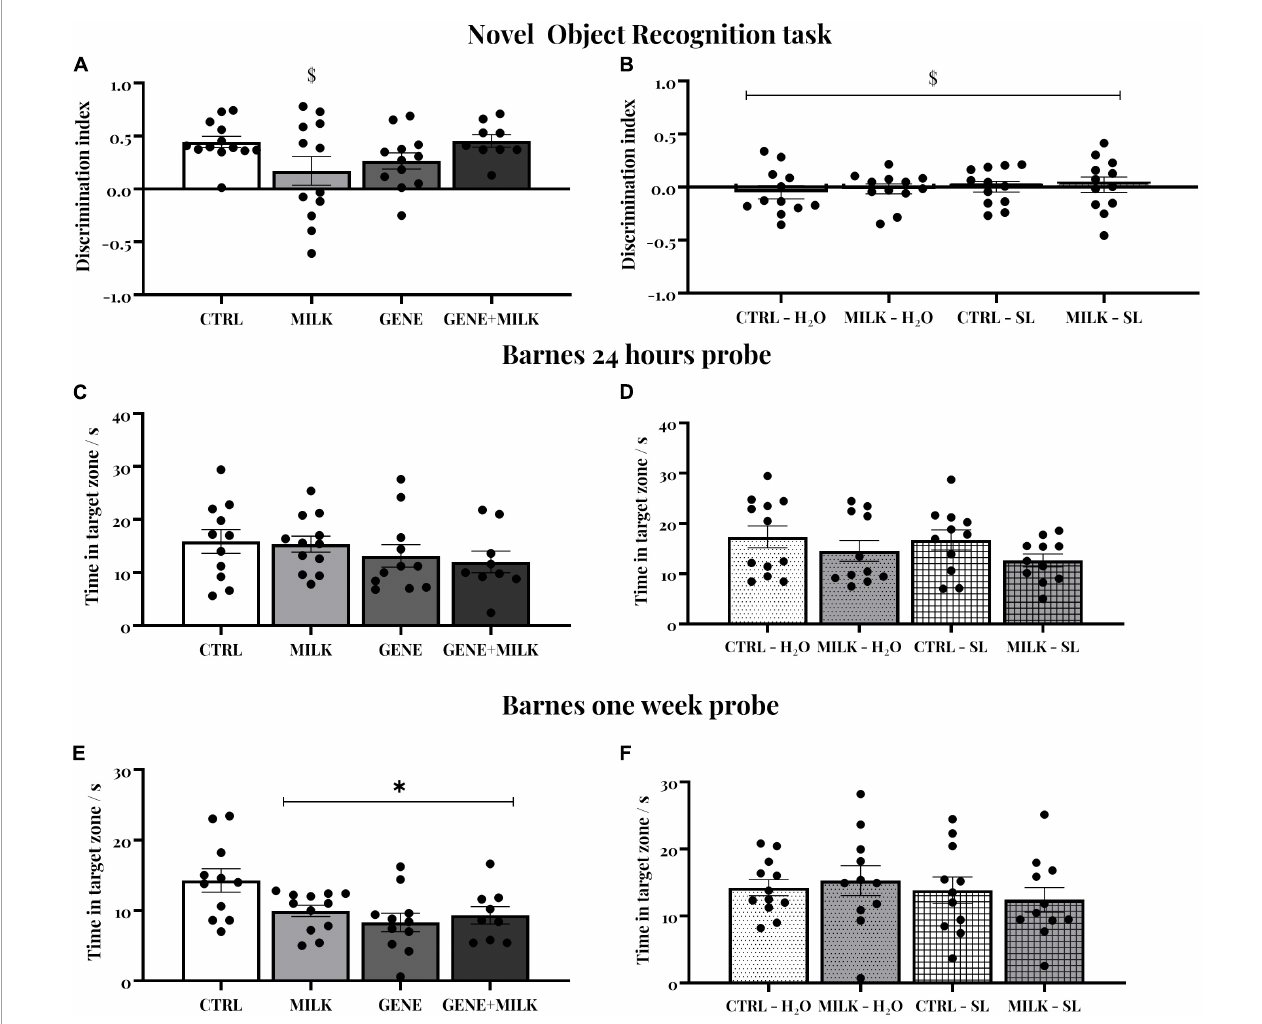
FIGURE3 (A,B) Novel object recognition (NOR) test: Discrimination index for the novel object during 10-min test sessions performed 24 h after the familiarization phase in experiment 1 (A) and experiment 2 (B) . The dashed lines represent the chance level. $ indicate that experimental groups did not differ from the chance level. (C,D) Short-term spatial memory: time spent in target zone during the probe trial conducted 24 h after the last day of training in the experiment 1 (C) and experiment 2 (D) . (E,F) Long-term spatial memory: time spent in the target zone during the probe trial conducted 7 days after the last day of training. In experiment 1 (E) , all groups showed reduced long-term spatial memory compared to the CTRL group. ∗ p < 0.05 in post-hoc tests compared to CTRL group.